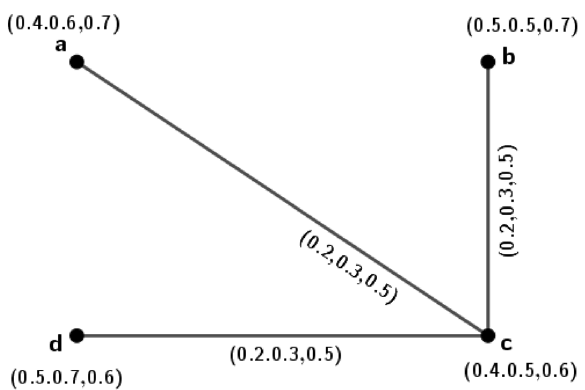
Figure 5. Antipodal 3PFG A (Γ 2 )